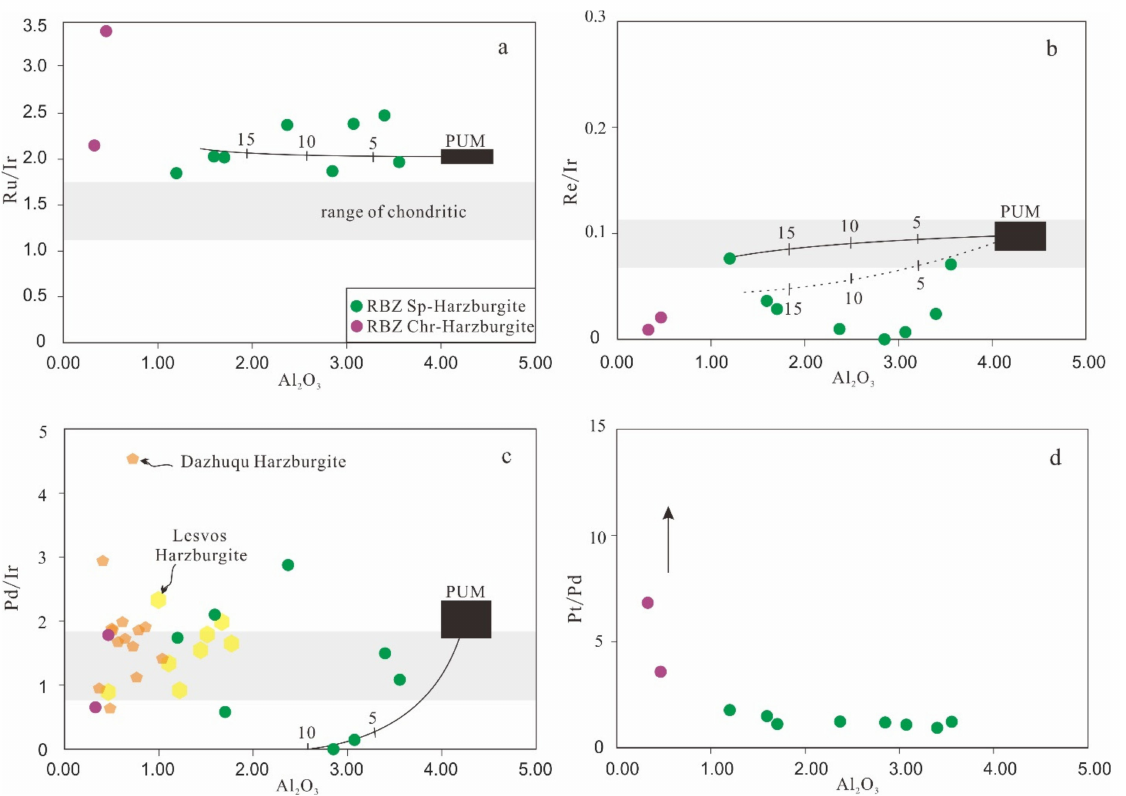
Figure 10. Diagrams of correlation between whole-rock Ru/Ir ( a ), Re/Ir ( b ), Pd/Ir ( c ), Pt/Pd ( d ) (inhomogeneous) and Al 2 O 3 (wt.%) of Raobazhai peridotites. The solid line in Figure ( a – c ) are from [49], that the composition of the remaining peridotite after partial melting of sulfide solid solution (MSS)-sulfide melt is balanced. The dotted line in ( b ) represents the overall distribution of moderately incompatible Re. The composition of PUM comes from [30]. Range of chondritic Ru/Ir, Re/Ir, Pd/Ir are from [50]. Data of Dazhuqu and Lesvos are from